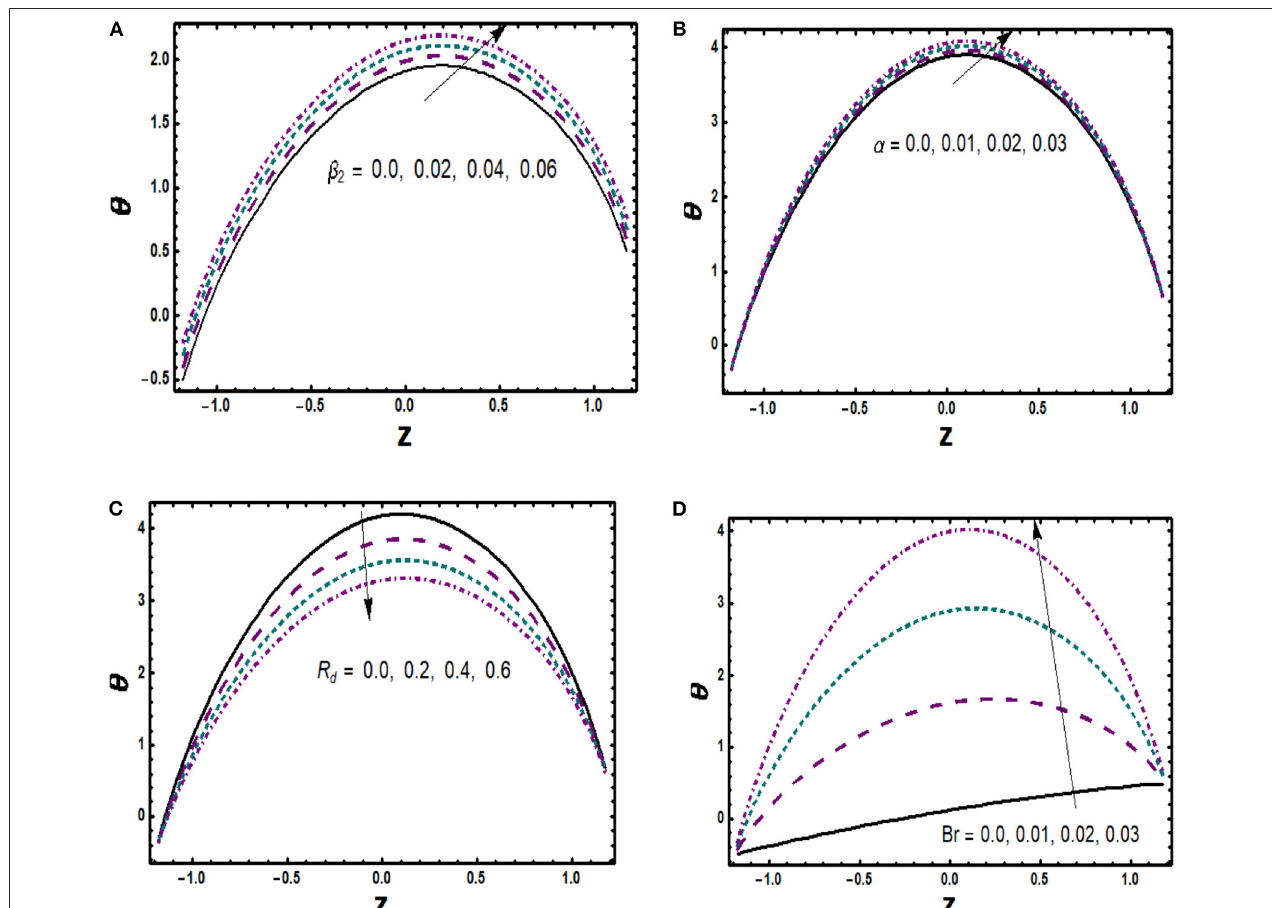
FIGURE 8 | (A–D) Effects of β 2 , α , R d , and Br on θ ( z ) .